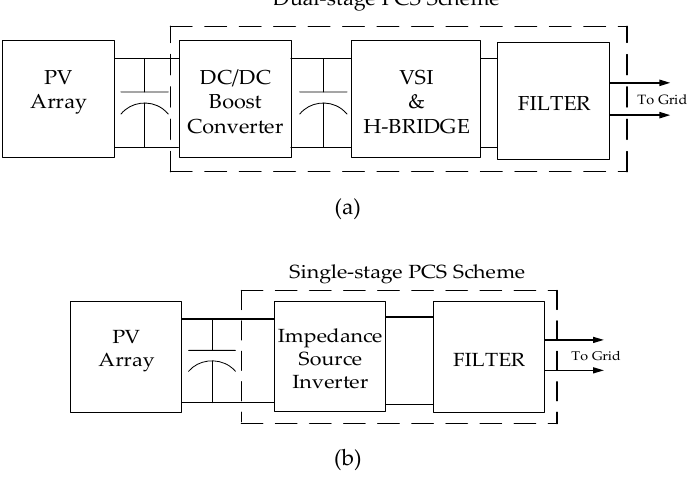
Figure 1. Photovoltaic (PV) power conditioning scheme: ( a ) traditional dual stage conversion and ( b ) Z-source inverter (ZSI) based single-stage conversion.